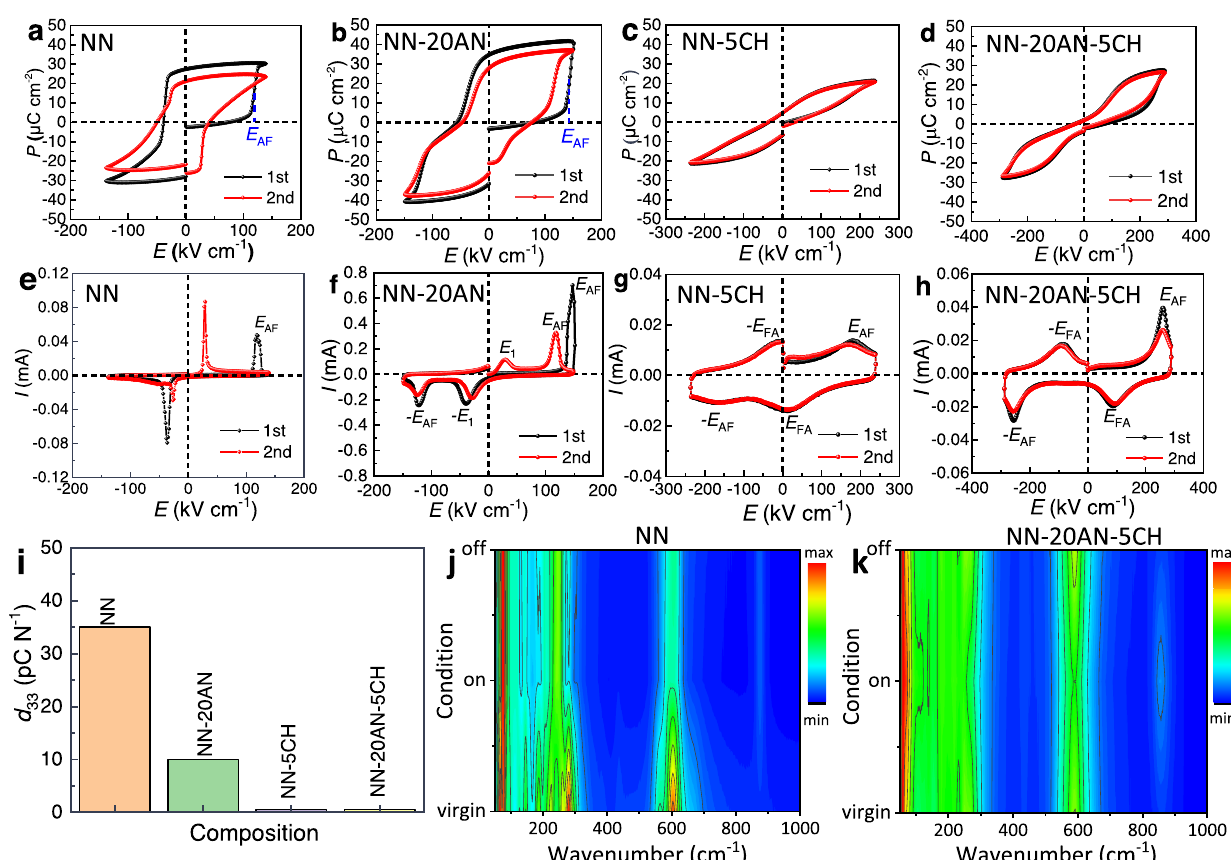
Fig. 3 | The reversible behavior of the newly designed NN-based ceramics. The fi rst and second circles of P – E loops and I – E curves for ( a ) and ( b ) NN; ( c ) and ( d ) NN-20AN; ( e ) and ( f ) NN-5CH; ( g , h ) NN-20AN-5CH. i The piezoelectric coef fi cient d 33 for the poled samples. The Raman spectra under various conditions of virgin